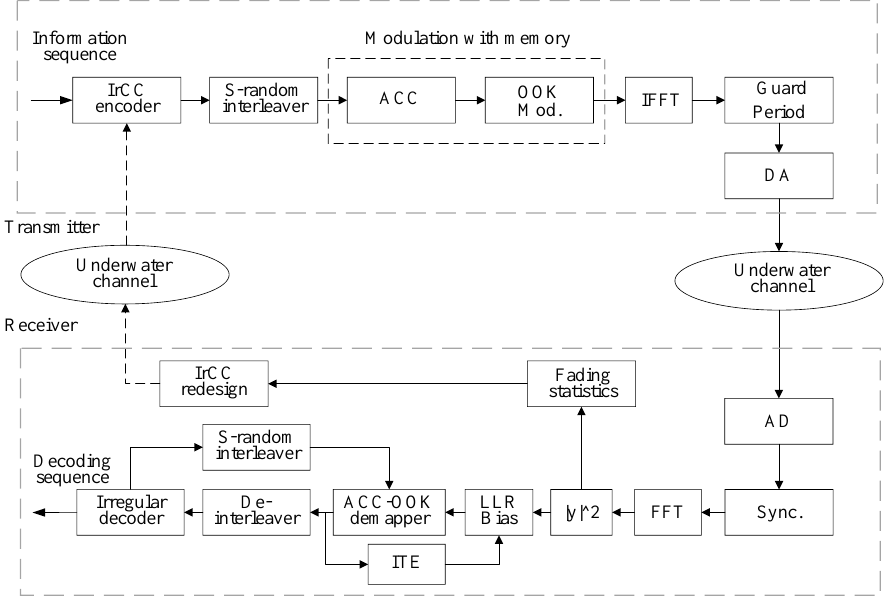
Figure 1. Block diagram of the proposed noncoherent UAC (underwater acoustic communication)